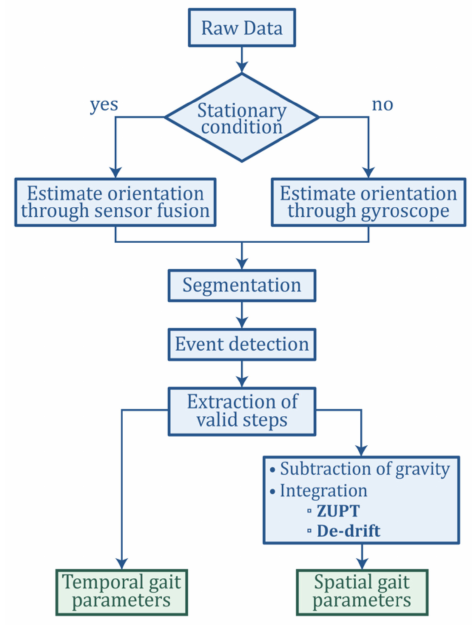
Figure 7. The flowchart of the data processing procedure.